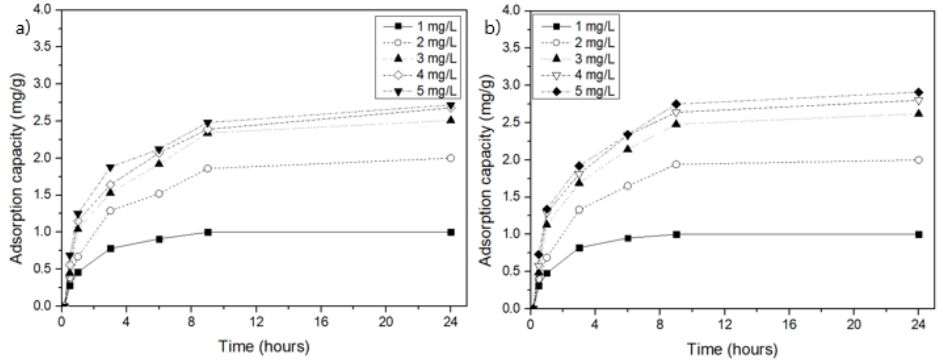
Figure 5. NH 4 -N adsorption capacities of MSSB and PB at different initial NH 4 -N concentrations: ( a ) MSSB, ( b ) PB.